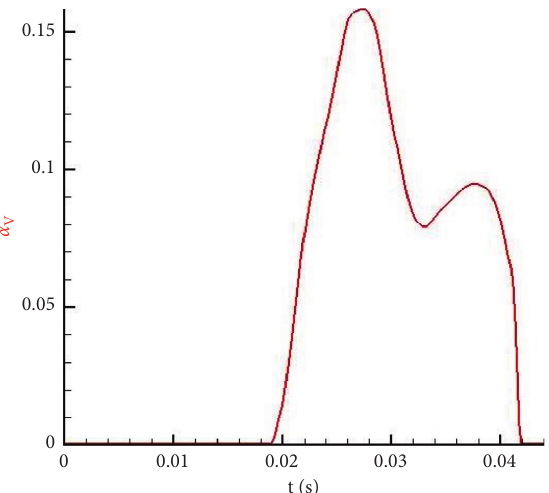
Figure 5: Curve chart of the mean value of volume fraction of no.1 plunger cavity [30].